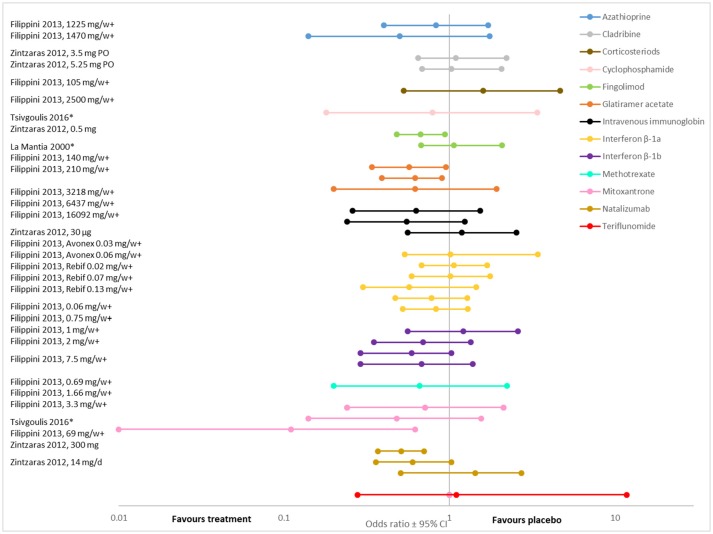
The odds of disease progression (measured as accumulated disability) presented here for comparison (odds ratio ± 95%CI after treatment with various DMT compared to placebo, values
<1 indicate an effect). For each DMT, each line shows the results of a different meta-analysis/dosage combination. Source citation and dosages (if specified) are given in the data label. These could not be consolidated due to overlap in included studies between meta-analyses). * Indicates that the analysis was a traditional meta-analysis, all others were network met-analyses. + Indicates analyses that included all MS phenotypes, all others included only relapsing phenotypes.